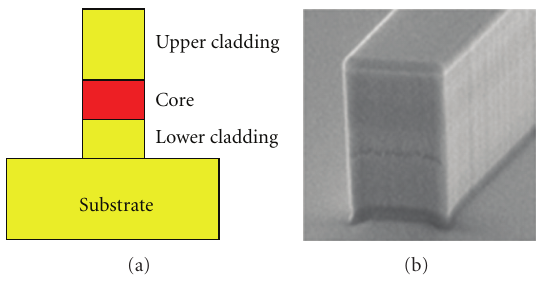
Figure 2: (a) Schematic and (b) SEM photo of the cross-section for a typical high-index-contrast ridge waveguide. High index contrast exists in the lateral direction at the core-air interfaces. The core could be InGaAsP or SiGe, and the claddings are InP or Si,